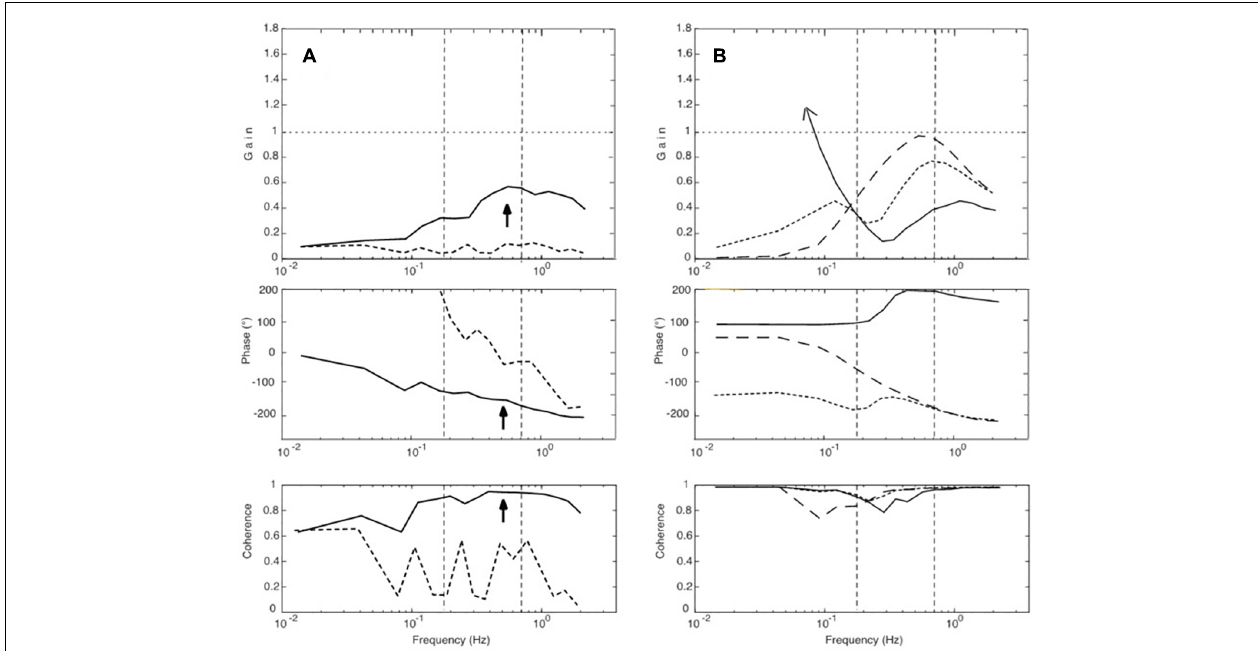
FIGURE 8 | (A,B) Further simulation results. (A) Effects of injecting low-frequency noise into the servo loop of the COM model ( Figure 4 ). Dotted curves give simulation results obtained with noise alone. When adding a weak support translation stimulus, the response (full lines) developed a resonance peak and a coherence of almost unity in the upper MFR (arrow) with a phase lag of approximately 180 ◦ . (B) Results of simulations that tested the theoretical hypothesis of an antagonism between visual and proprioceptive effects. The dashed curves represent sway responses obtained with proprioceptive feedback alone, full lines those with continuous visual feedback alone, and the dotted curves give the results obtained with the combination of both (note its resemblance to Figure 3C